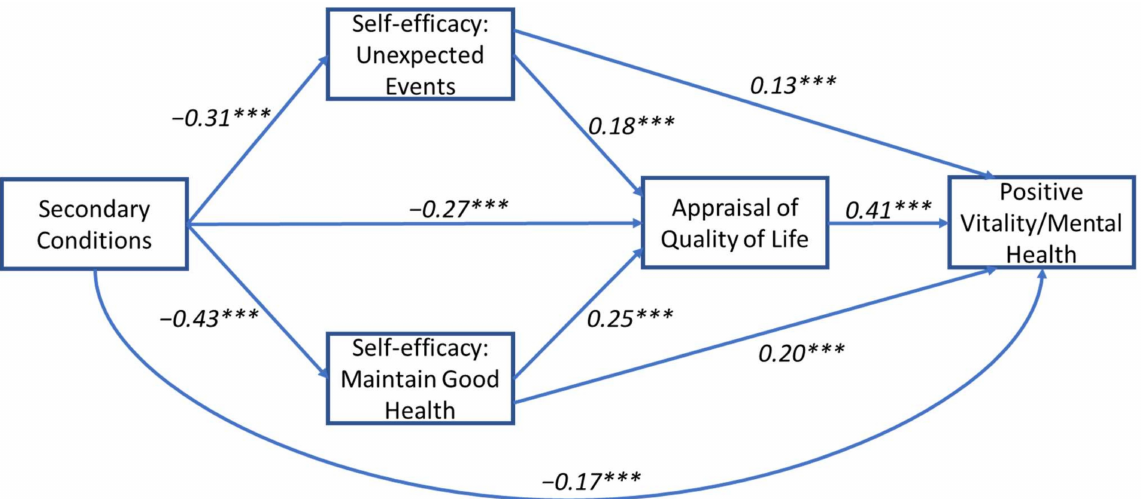
Figure 5. Mediation path model for the relationship between secondary conditions and positive vitality/mental health. Standardized regression coefficients ( β ) are presented for the direct paths. Model includes two parallel self-efficacy mediators (unexpected events and maintain good health) that are serially antecedent to a third mediator (self-appraisal of quality of life). Model is adjusted for age, sex, time since injury, and injury level. *** p < 0.001.